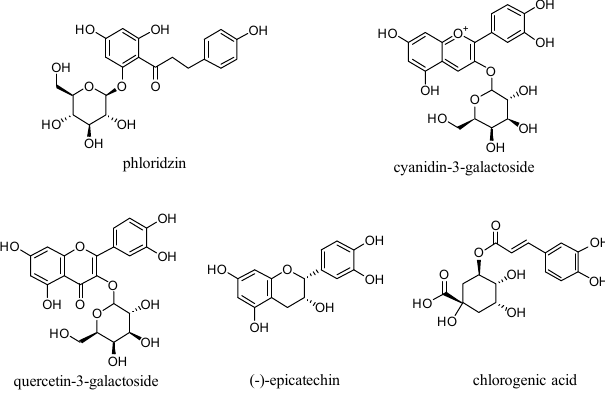
Fig. 1. Chemical structure of main polyphenolic constituents of industrial apple pomace. Fig 1. Chemical structure of main polyphenolic constituents of industrial apple